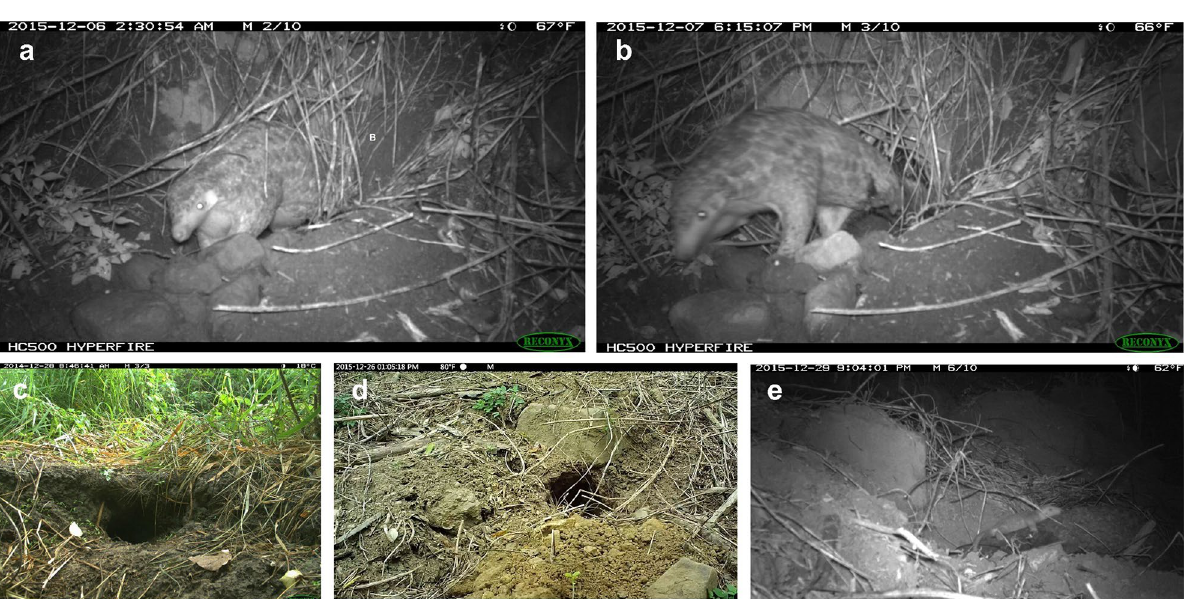
Figure 3. Determination of date of delivery and the parturition burrows used by a female Chinese pangolin Manis pentadactyla (code: LF28) . LF28 was still pregnant on Dec. 6, 2015 ( a ), and already delivered on Dec. 7 ( b ). The parturition burrows for the first birth ( c ) and the second birth ( d ). LF28 carried the second infant pangolin on Dec. 29, 2015 ( e